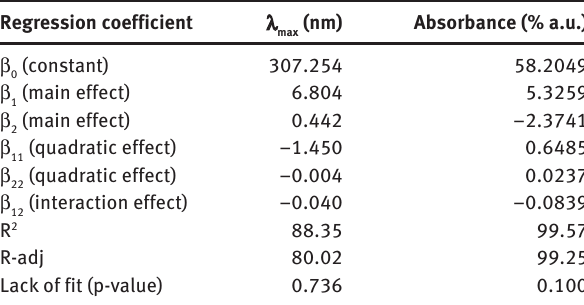
Table 2: Regression coefficients, R 2 , R 2 -adj, and probability values for the fitted models.